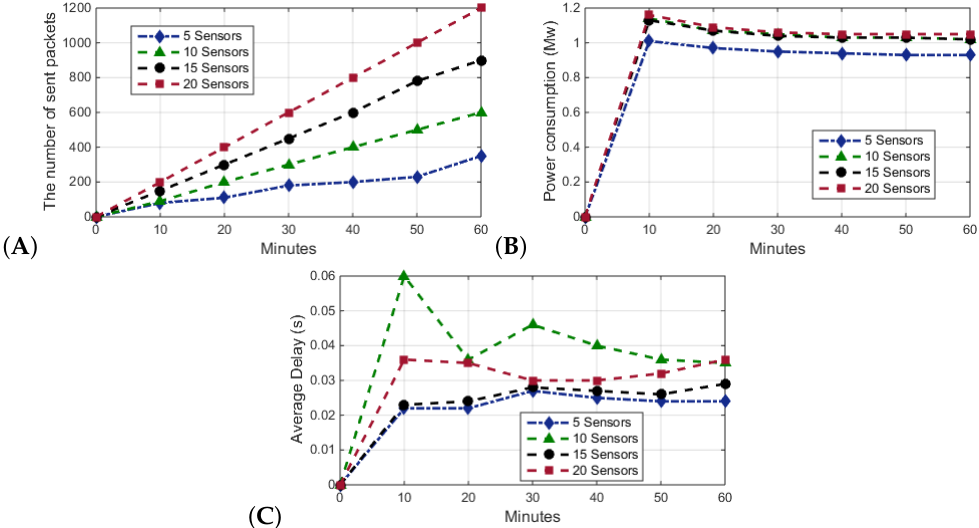
Figure 7. Performance evaluation of our IoT network. ( A ) Number of sent packets (messages overhead). ( B ) Power consumption of sensor nodes. ( C ) Sending delay (delay